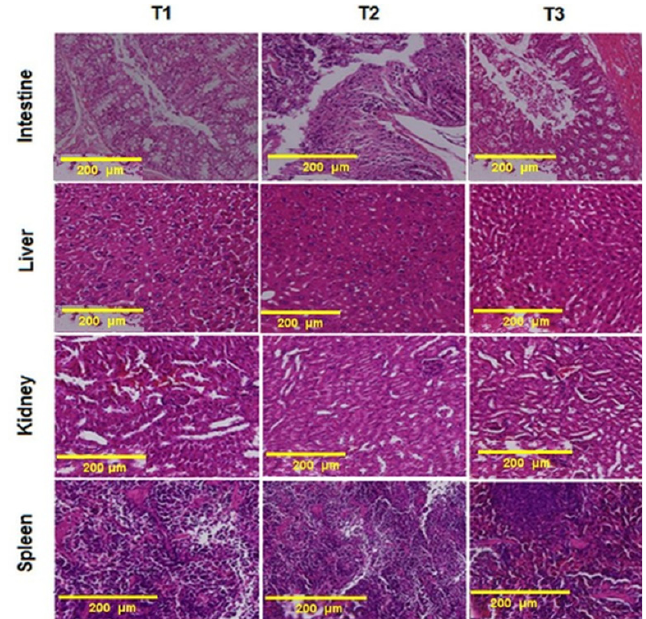
Figure 4. The histopathological changes in the mice intestine, liver, kidney and spleen challenged by colorectal cancer. T1: induced colorectal cancer, T2: induced colorectal cancer received 100 mg/kg/day phenolics, T3: induced colorectal cancer received 100 mg/kg/day nanoliposome-loaded phenolics.